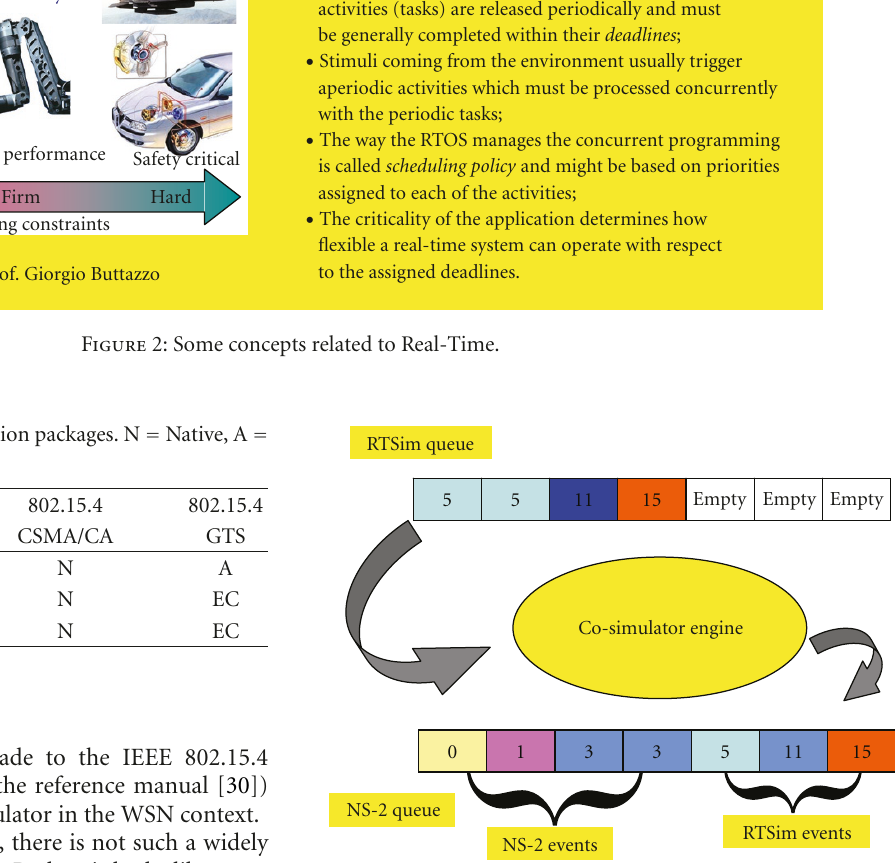
Figure 3: Synchronization of the NS-2 and RTSim